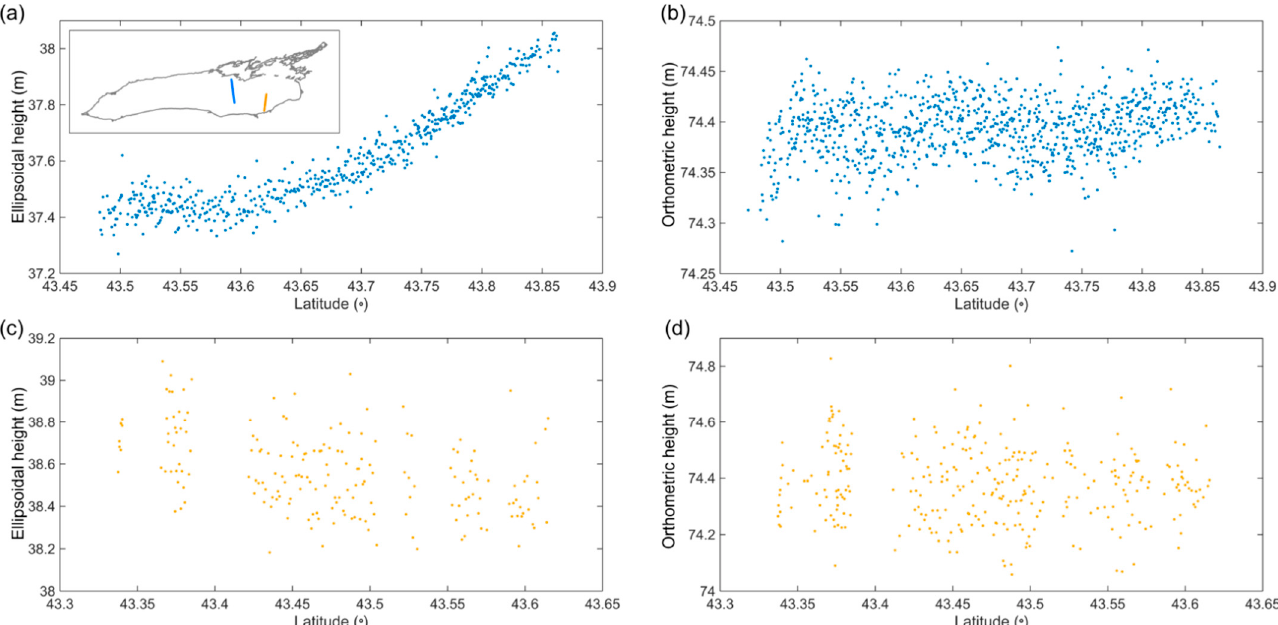
Figure 7. Comparisons of along-track surface heights in Lake Ontario (i.e., the 7th lake in Figure 6) from ATL08 products and ATL13 products. ( a ) Surface heights based on the ellipsoidal height from ATL08 products on 5 January 2019; ( b ) surface heights based on the orthometric height from ATL13 products on 5 January 2019; ( c ) surface heights from ATL08 products on 6 February 2019; ( d ) surface heights from ATL13 products on 6 February 2019. The subset in ( a ) represent two laser tracks of ICESat ‐ 2 (blue: 5 January 2019, yellow: 6 February 2019).